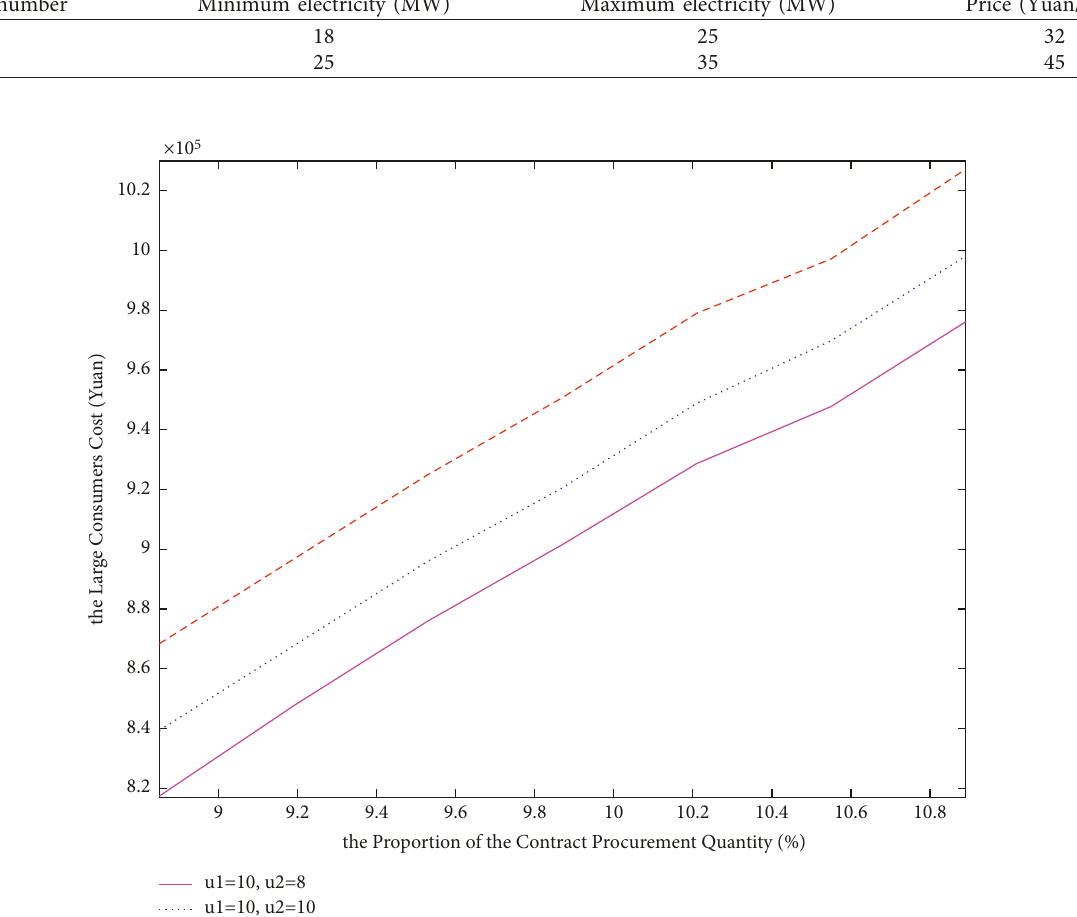
Figure 4: The impact of the proportion of the contract procurement quantity on the large consumer’s